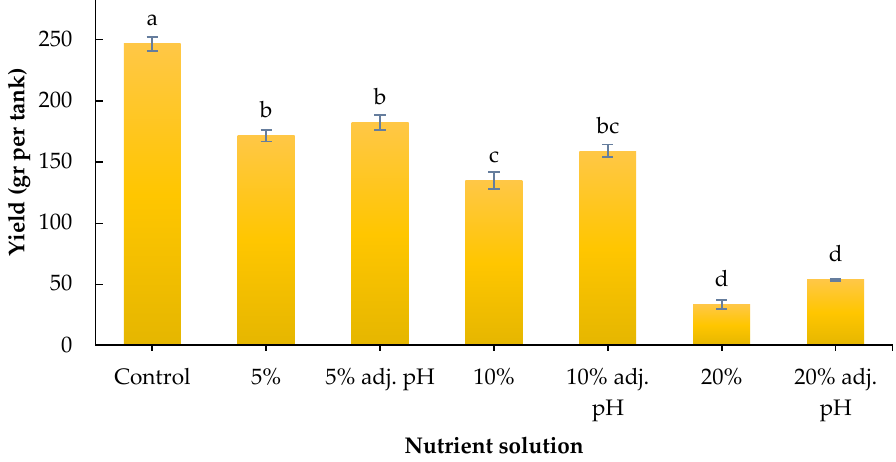
Figure 3. Yield (gr/tank) of baby lettuce grown under different digestate solutions. Columns (means ± SE) with different letters are significantly different ( p < 0.05).